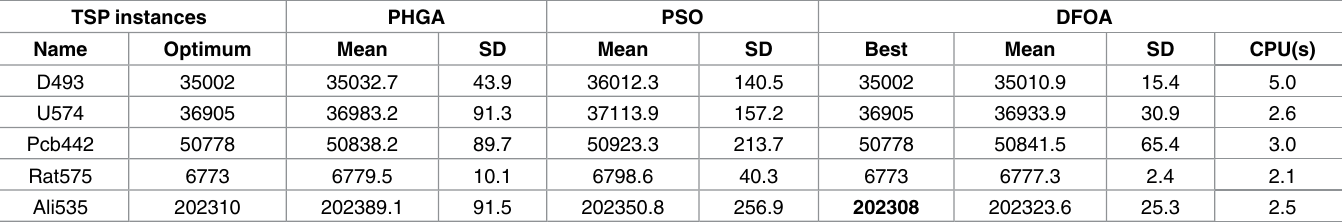
Table 1. Comparison of the DFOA, PHGA, and PSO on small-scale TSP instances after 20 repetitions. TSP instances